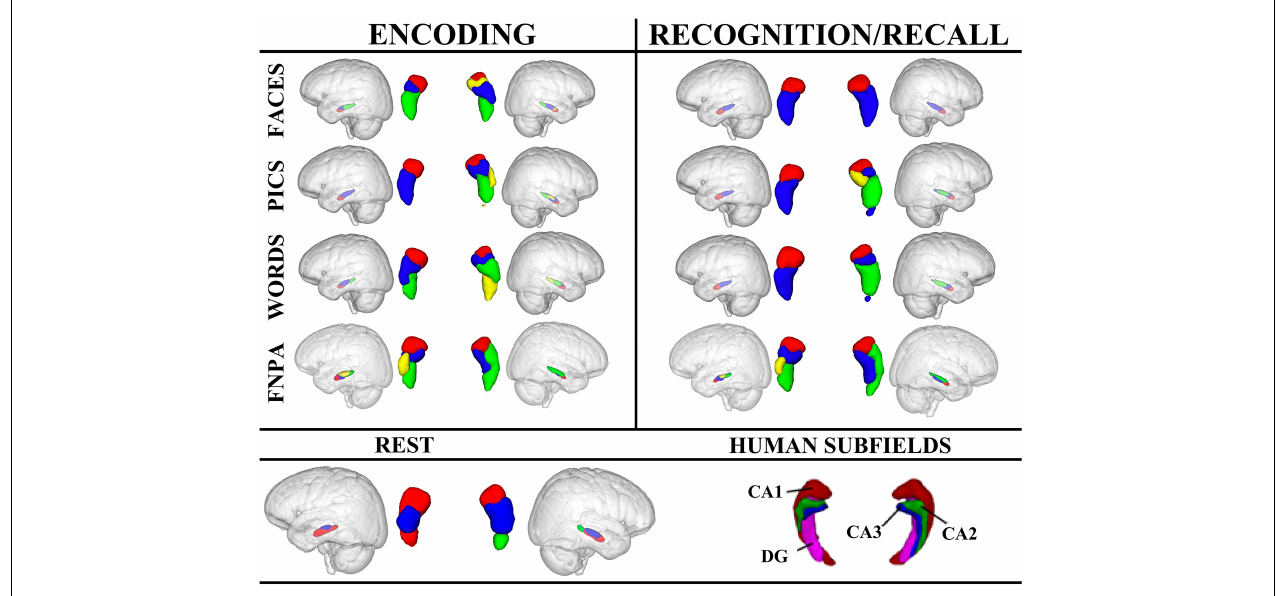
FIGURE 4 | Hierarchical clustering results for left and right hippocampi across tasks and conditions. Human hippocampus subfields are also presented for reference. For encoding, the left anterior hippocampal cluster, depicted in red, appears to align with CA1, while in the right hippocampus, the anterior-most cluster may also encompass portions of CA2 (yellow) in addition to CA1. Clustering in the right hippocampus during the FNPA task appears to alright with CA1 (red), and CA1/CA2 (green) and CA3/DG (blue). FNPA, face-name paired associate task; DG, dentate